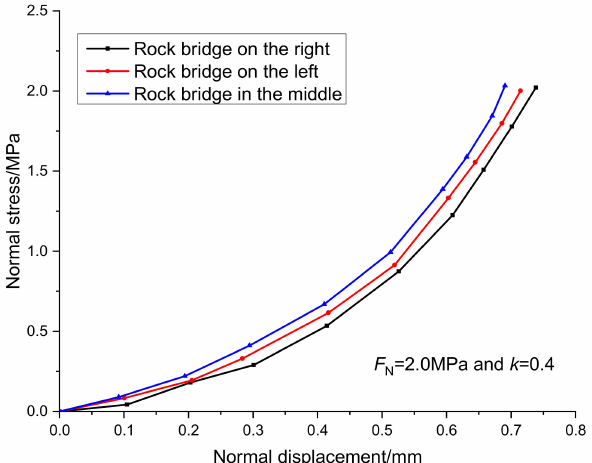
Figure 12. Relationship curves between normal stress and normal displacement under di ff erent arrangement of the rock bridge.